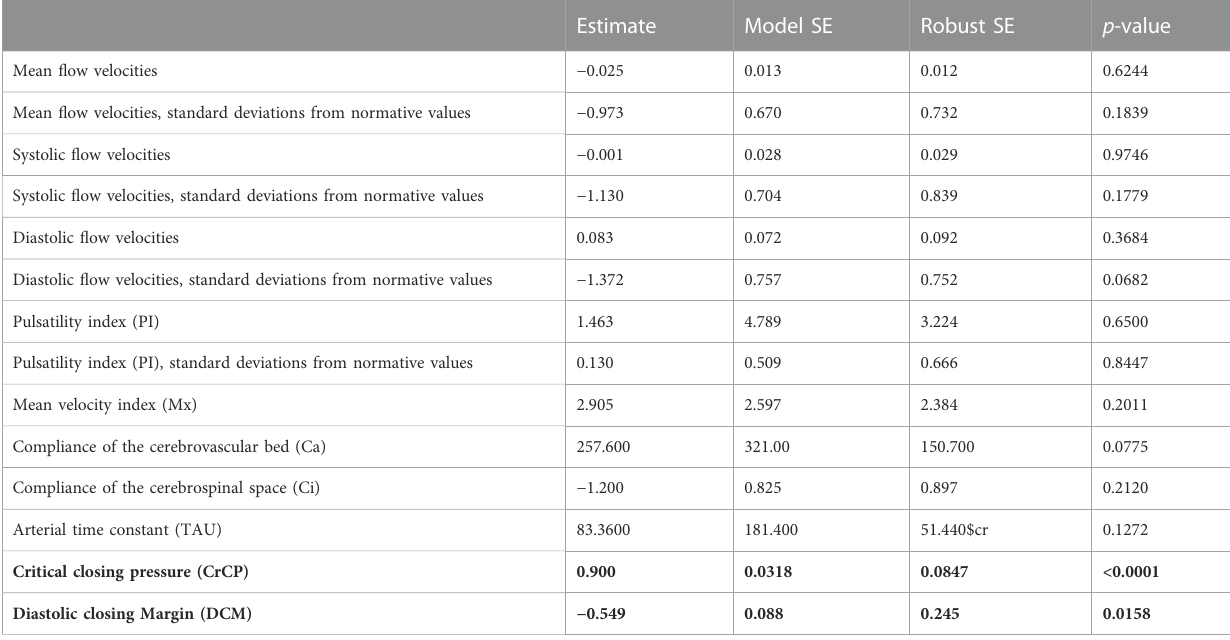
TABLE 4 Association of TCD characteristics with intracranial